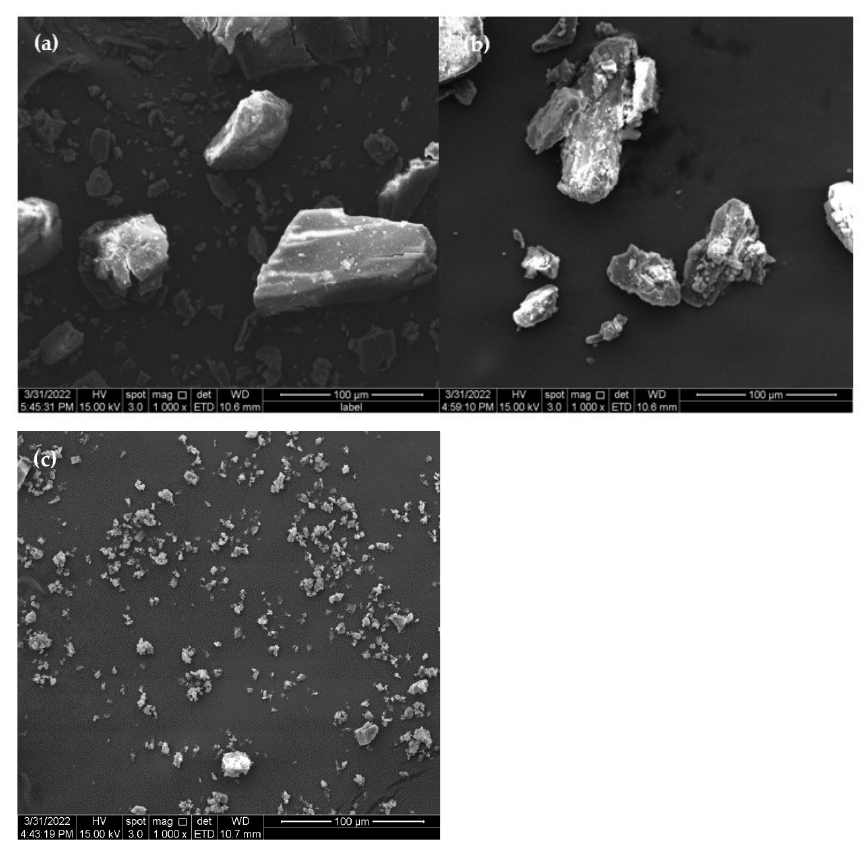
Figure 3. The SEM images. ( a ) β-CD; ( b ) PM; ( c ) β−CD/EO IC